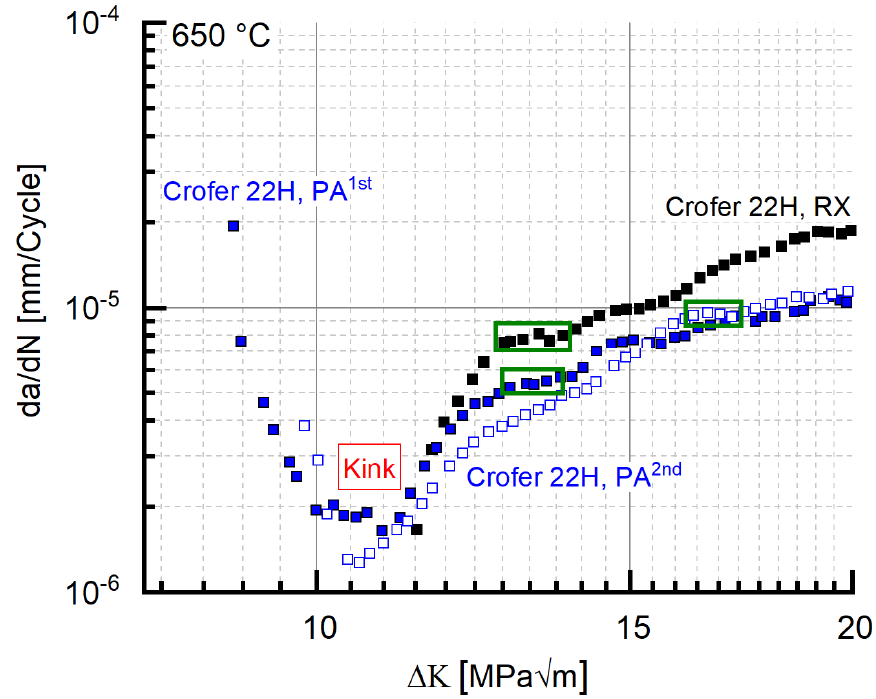
Figure 7. FCG data of Crofer ® 22H in the RX and the PA state (f = 20 Hz, T: 650 °C).